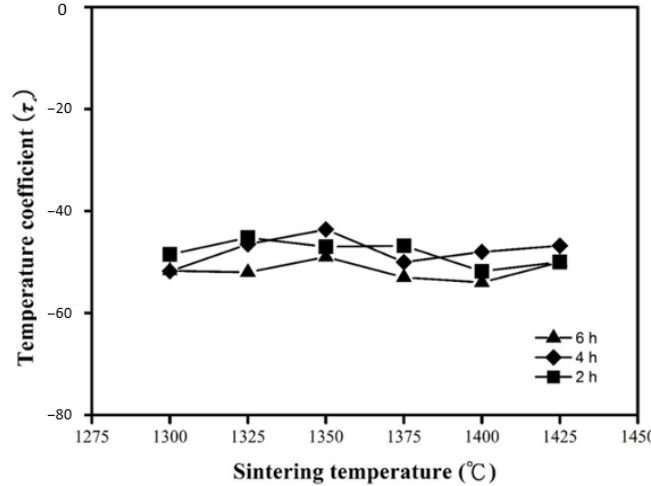
Figure 7. Dependence of τ f value on sintering temperature of MNT ceramics for varied holding times.